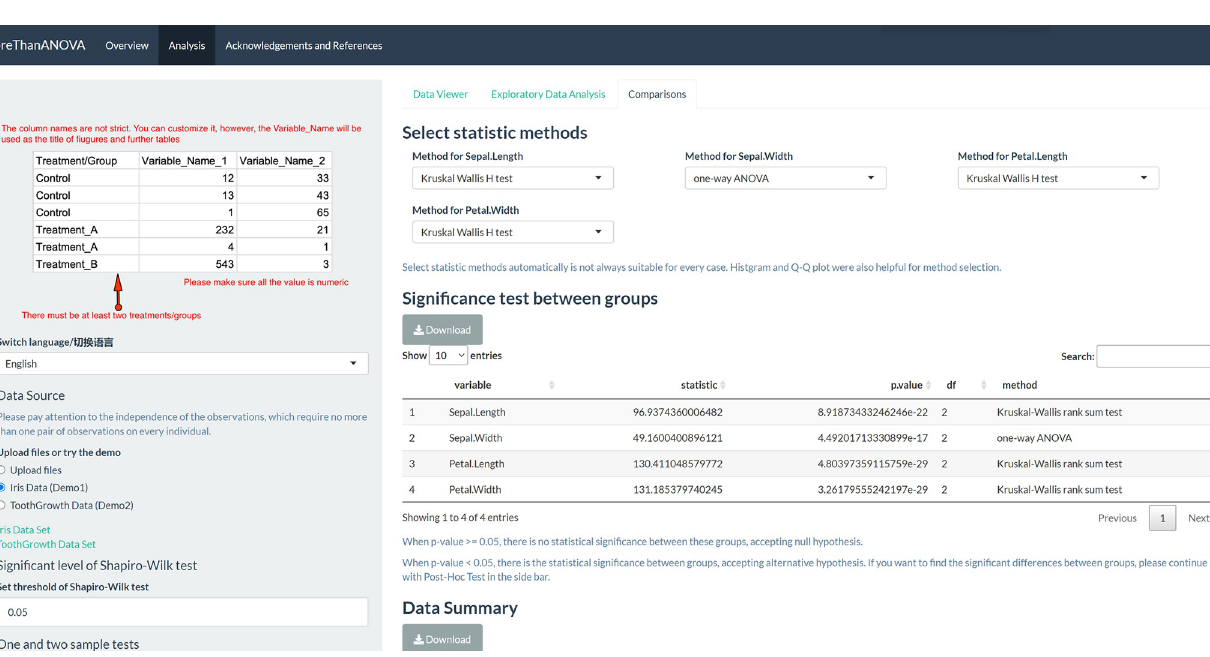
Fig 1. The user interface of Comparisons tab of moreThanANOVA. Reprinted under a CC BY license, with the permission from Han Chen, original copyright 2022.